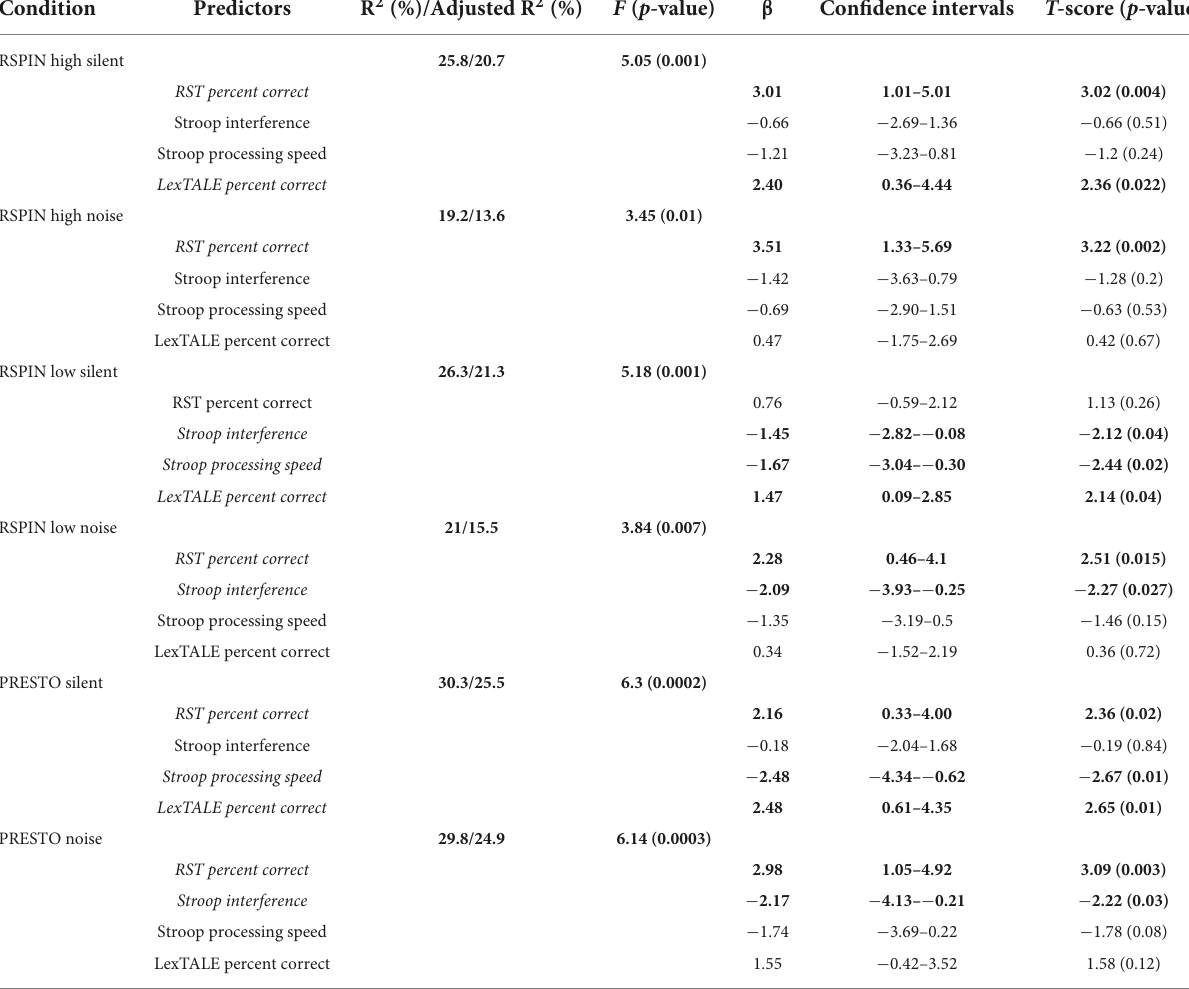
TABLE 4 Linear regression analysis models predicting perceptual restoration by sentence